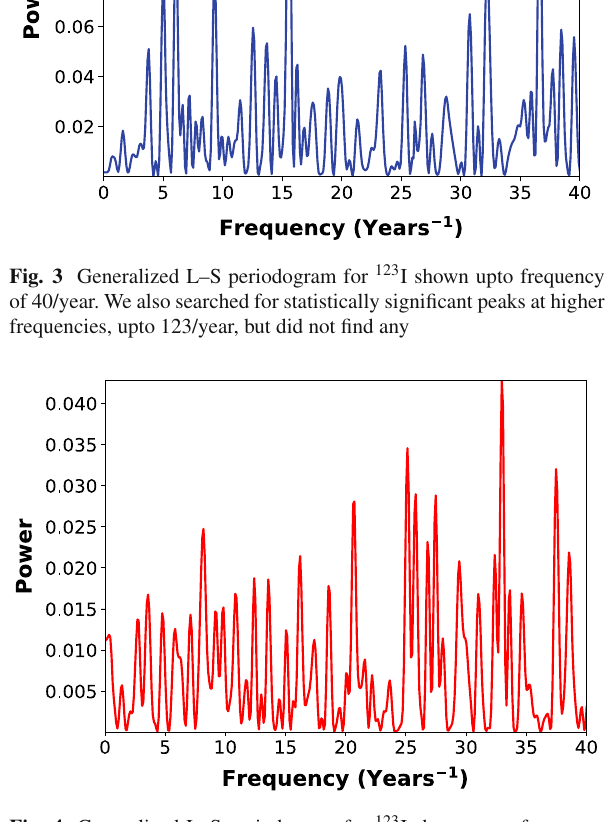
Fig. 4 Generalized L–S periodogram for 123 I shown upto frequency of 40/year. We also searched for statistically significant peaks at higher frequencies, upto 123/year, but did not find